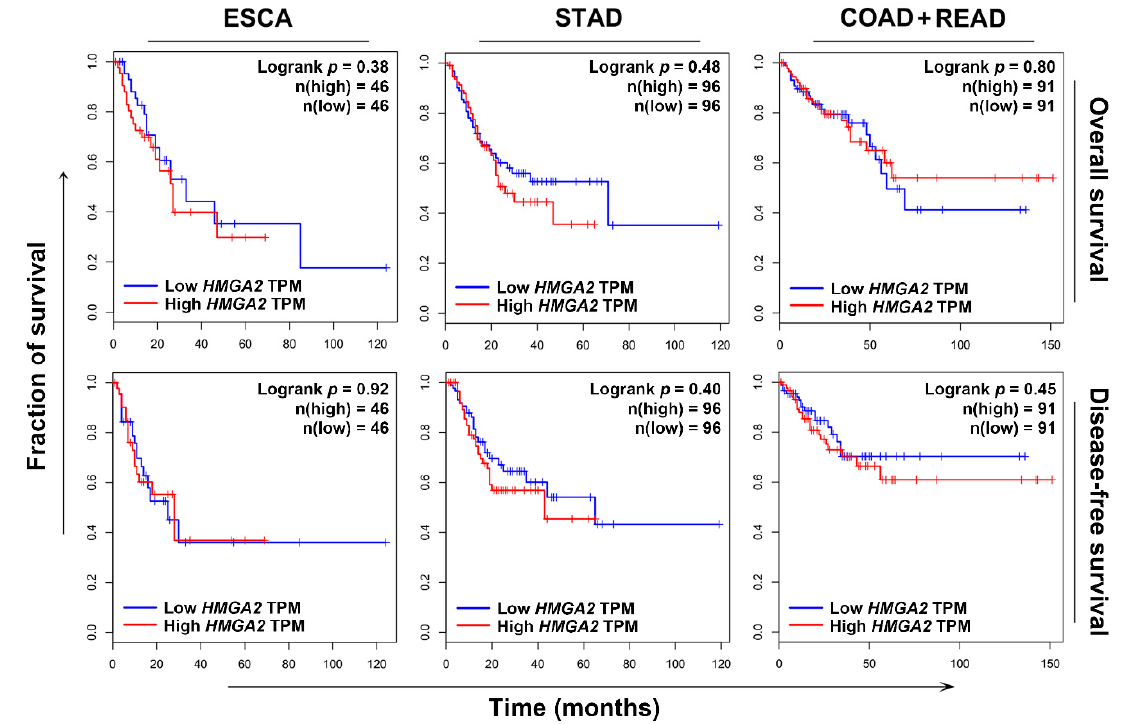
Figure 2. The prognostic impact of HMGA2 on overall and disease-free survival of cancer patients. The Kaplan–Meier survival plots for cancer patients with high and low HMGA2 expression were generated using the GEPIA database. TPM, transcript per million.